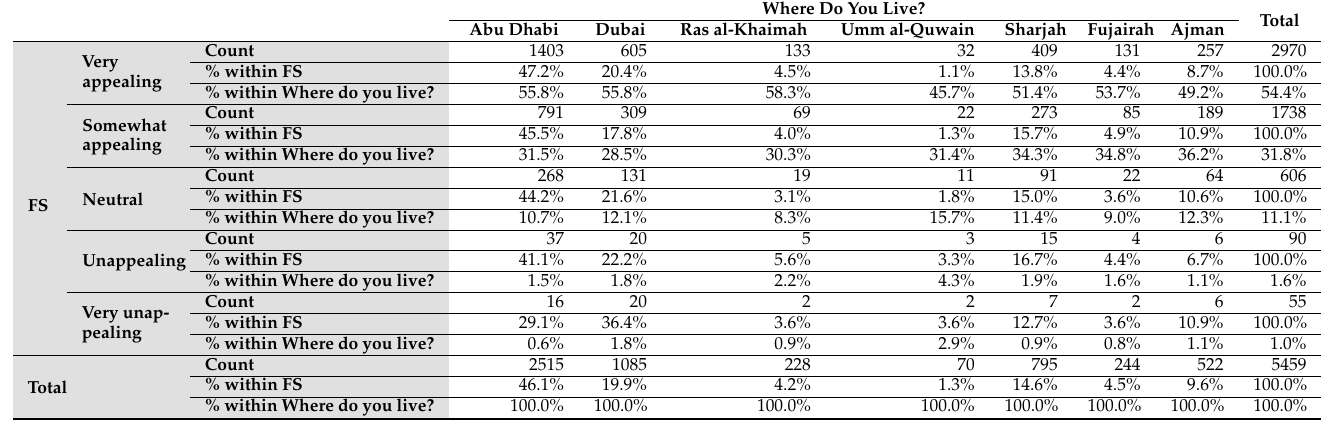
Table 24. Functional societal value of EVs and respondents’ emirates cross-tabulation.